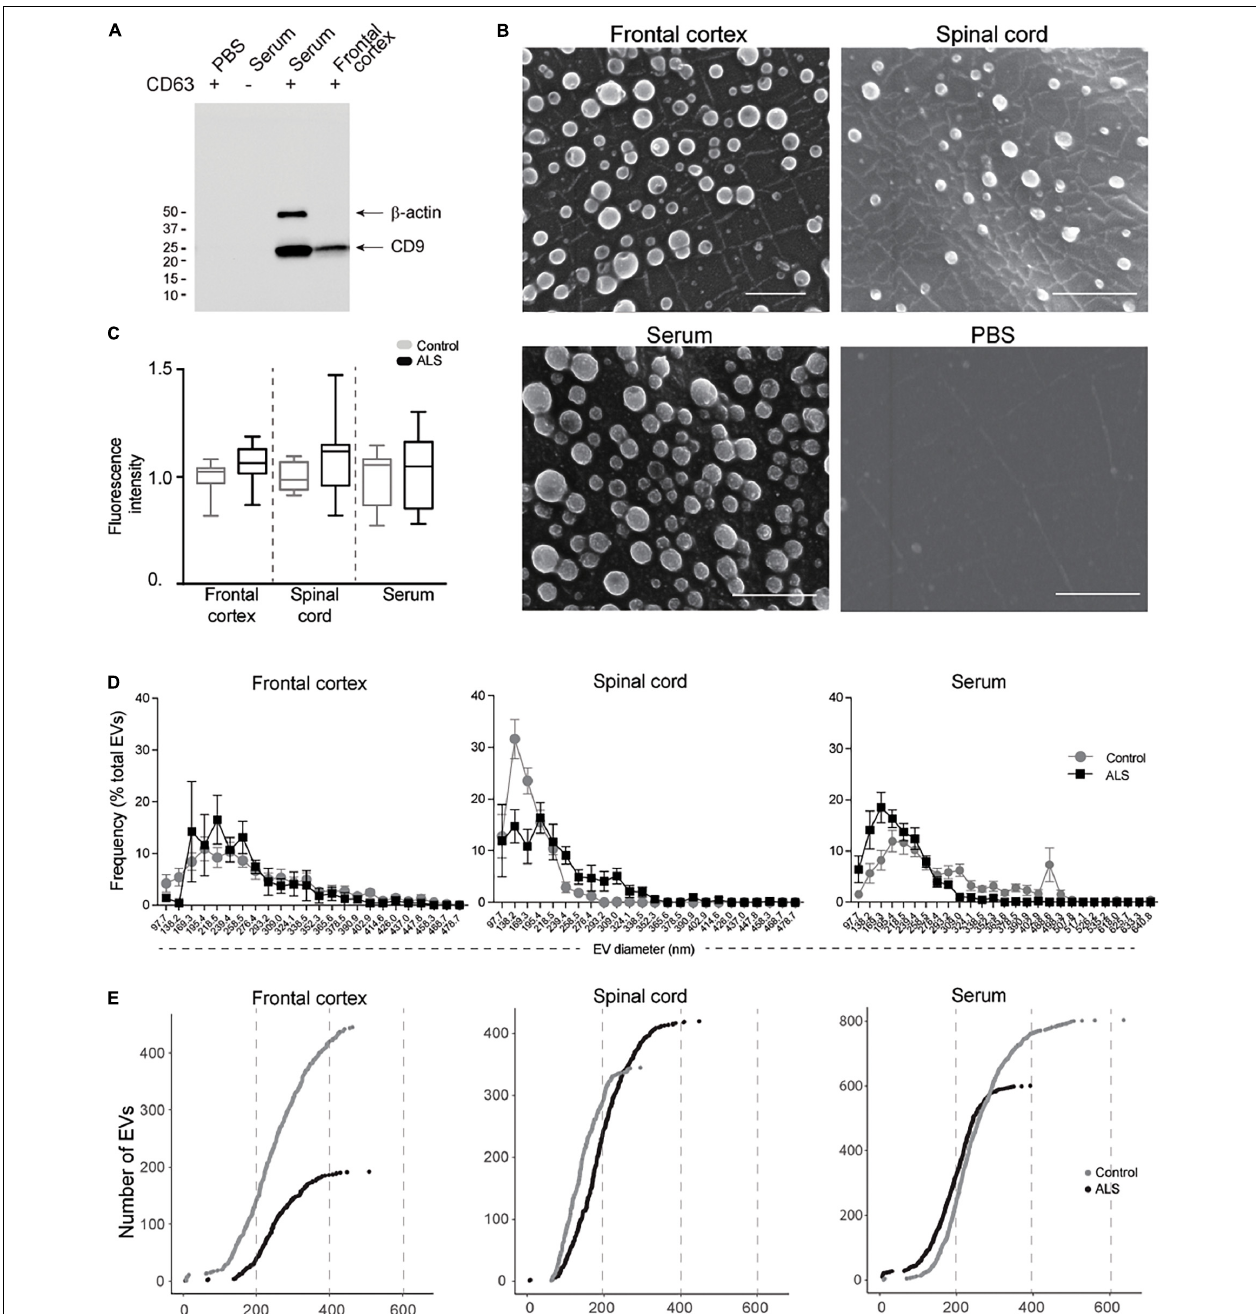
FIGURE 2 | EV characterization from frontal cortex, spinal cord, and serum of ALS and control participants. EVs were captured by ExoChip. (A) Protein characterization from frontal cortex and serum EVs captured from anti-CD63 coated or non-coated devices. Immunoblotting was performed for β -actin and CD9. (B) SEM micrographs (bars = 1 µ m). (C) On-chip immobilized and purified EVs were labeled with a fluorescent lipophilic dye (DiO). The fluorescence intensity values were normalized against the background. Fold-change is shown for minimum and maximum values with mean in a whisker plot. Frontal cortex (ALS = 12, Control = 8), spinal cord (ALS = 12, Control = 6), and serum (ALS = 7, Control = 9). (D) Size profile and frequency (%) by EV size measured from SEM micrographs in (B) . Data are presented as mean ± s.e.m.; ALS (black), healthy controls (gray). Frontal cortex (ALS = 191 EVs from 2 ALS participants, Control = 446 EVs from 3 healthy controls), spinal cord (ALS = 325 EVs from 3 ALS participants, Control = 441 EVs from 3 healthy controls), and serum (ALS = 601 EVs from 3 ALS participants, Control = 804 EVs from 3 healthy controls). (E) Cumulative plots for each tissue show the number of EVs and their corresponding diameter for ALS (black) and control (gray)